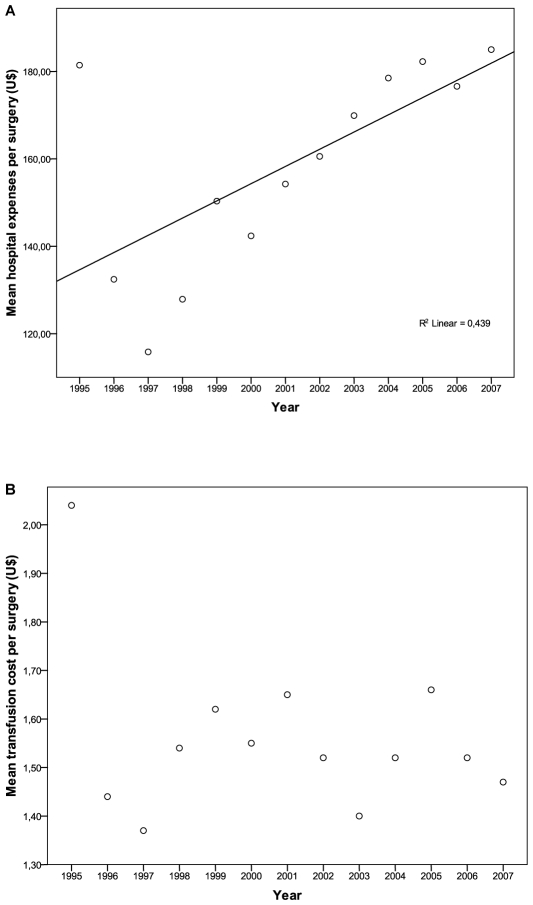
Trend analysis of economical data adjusted for monetary depreciation.A – Mean in-hospital expense per surgery. B- Mean transfusion cost per surgery.